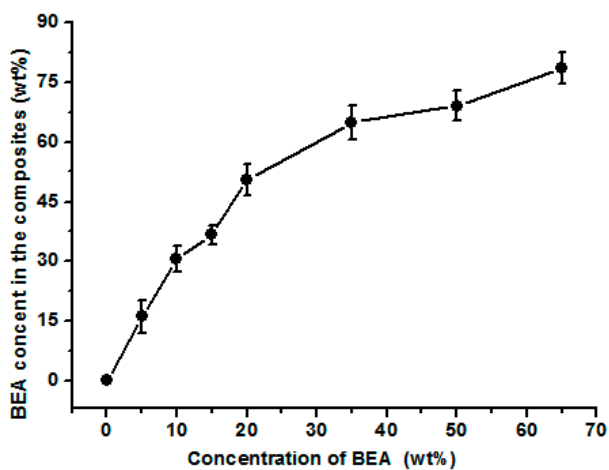
Figure 2. The influence of the concentration of the biphenyl A epoxy acrylate prepolymer on the content of the cured resin in the composite films.